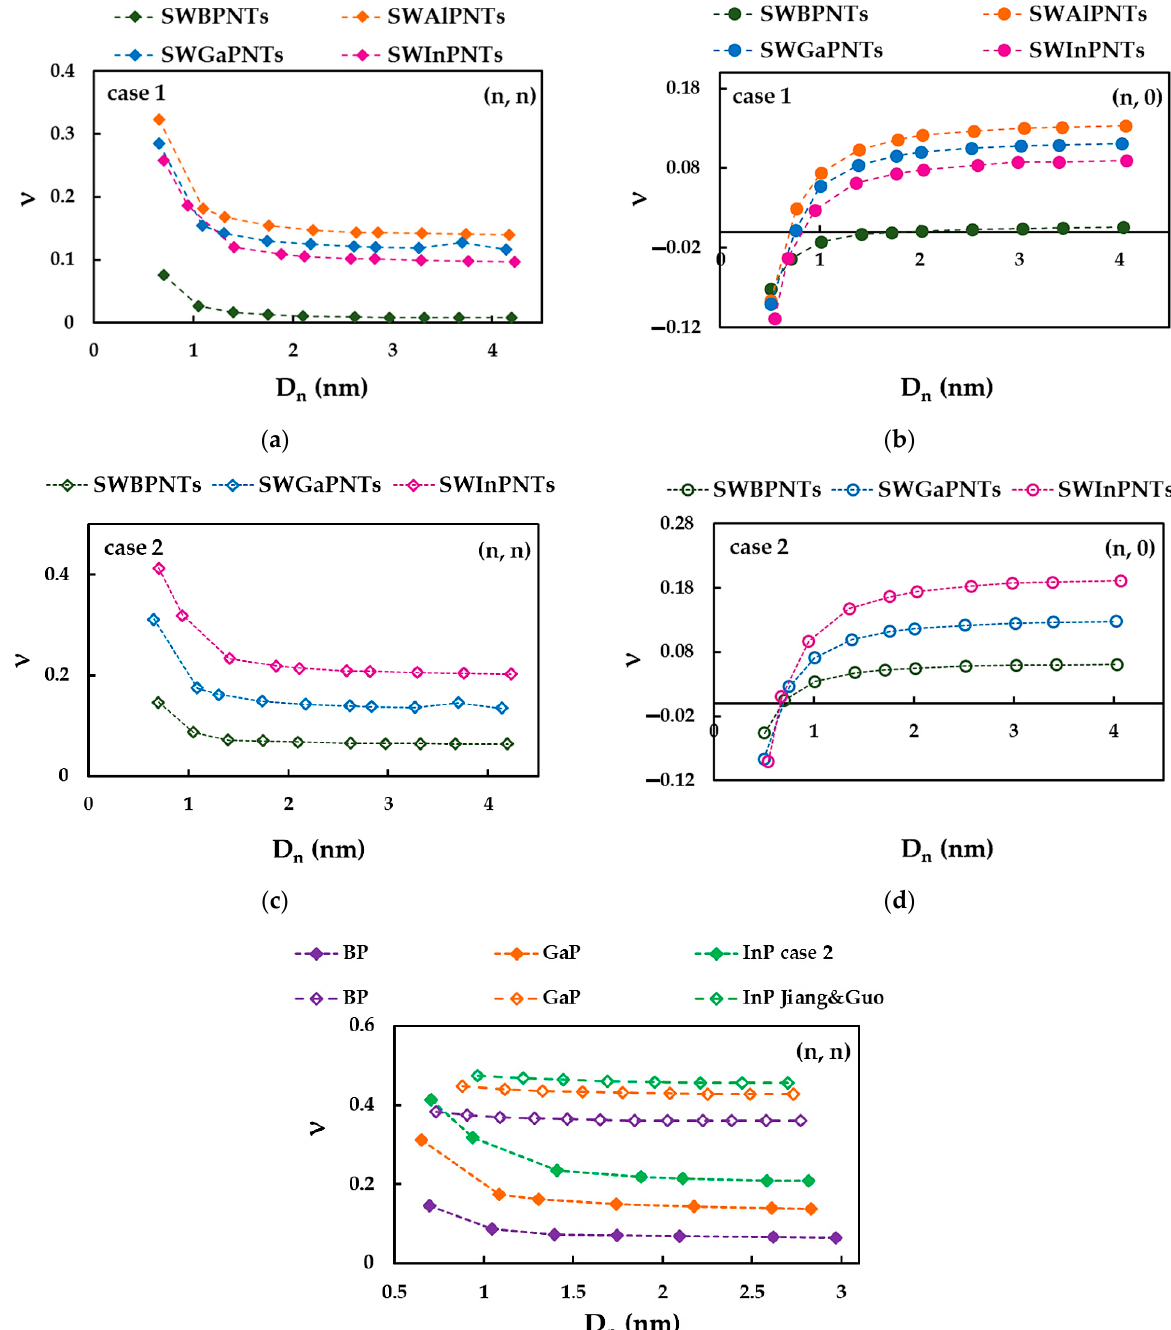
Figure 18. Evolution of the Poisson´s ratio, ν , as a function of the nanotube diameter, D n , for: ( a ) (n, n) SWBPNTs, SWAlPNTs, SWGaPNTs and SWInPNTs, case 1, ( b ) (n, 0) SWBPNTs, SWAlPNTs, SWGaPNTs and SWInPNTs, case 1, ( c ) (n, n) SWBPNTs, SWGaPNTs and SWInPNTs, case 2, ( d ) (n, 0) SWBPNTs, SWGaPNTs and SWInPNTs, case 2, and ( e ) (n, n) SWBPNTs, SWGaPNTs and SWInPNTs, case 2 and Jiang and Guo [27].